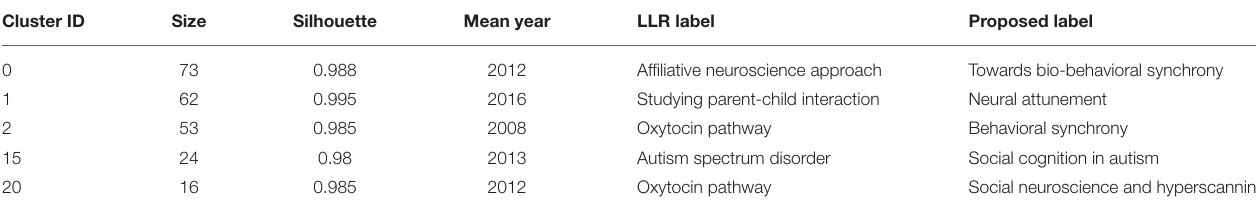
TABLE 2 | Metrics of the 5 clusters identified with the Document Co-citation Analysis (DCA). Cluster ID